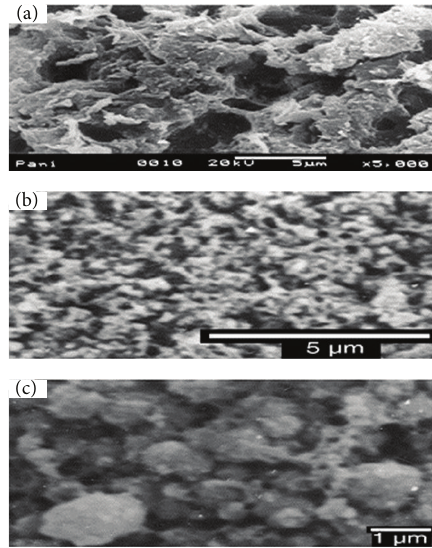
Figure 20: SEM images of (a) pure polyaniline, (b) PANI/Bi 2 Te 3 , and (c) PANI/Bi 2 Te 3